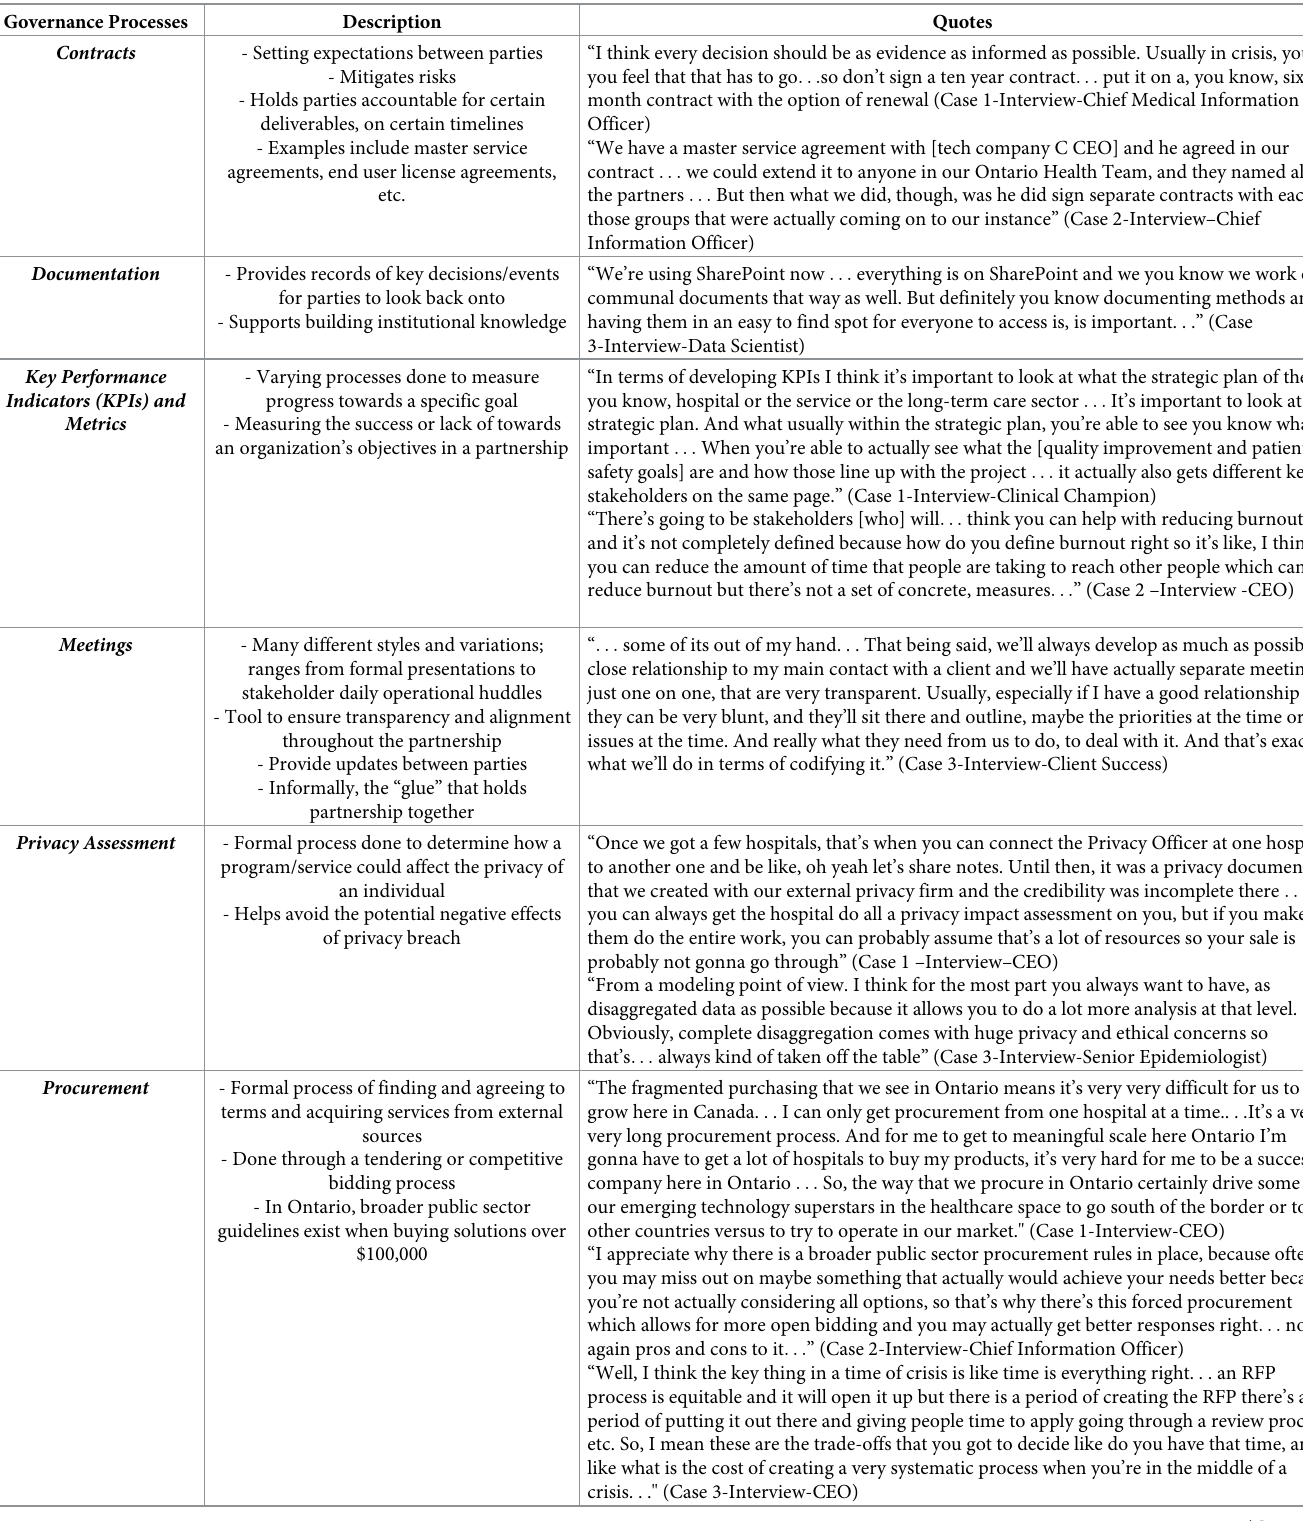
Table 3. Common government processes utilized across our three cases of